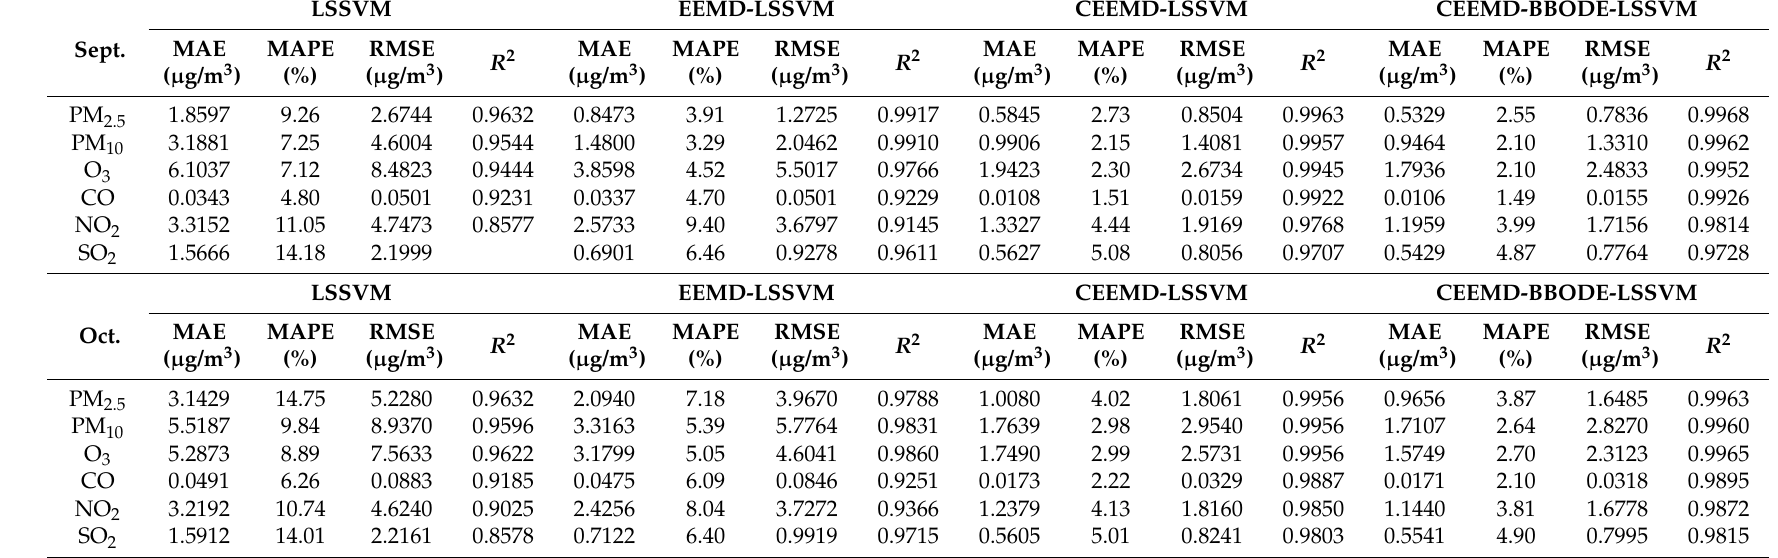
Table 8. Performance evaluations of all forecasting models for air pollutants in September and